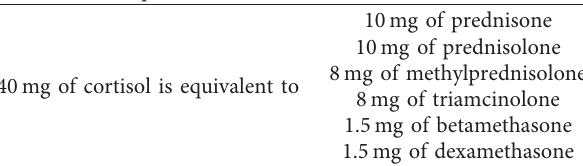
40 mg of cortisol is equivalent